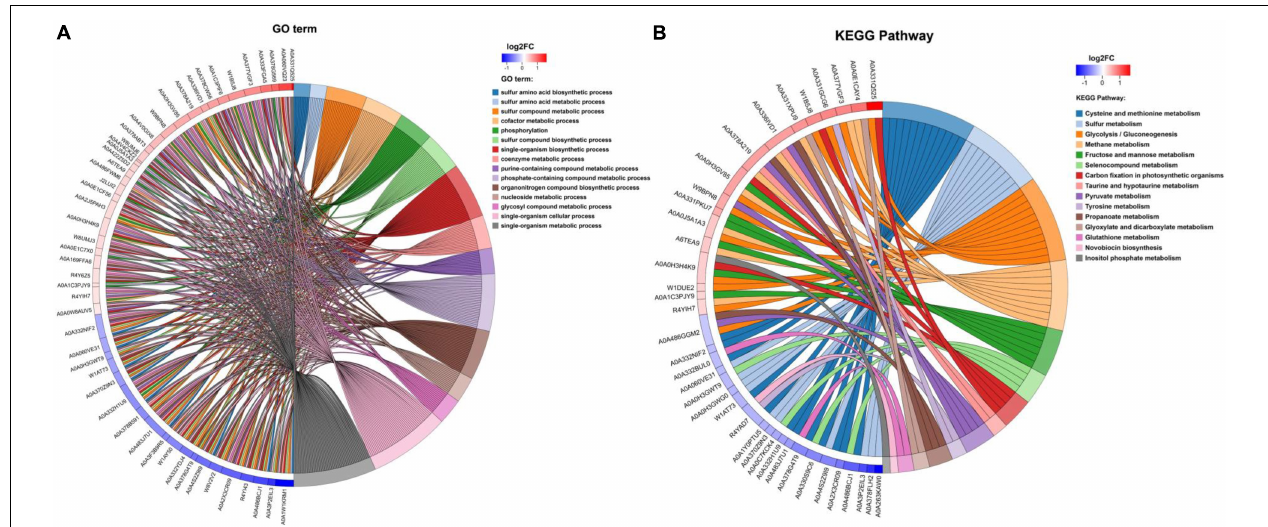
FIGURE 4 | (A) Chord diagram of GO term enrichment. (B) Chord diagram of KEGG pathway enrichment. KEGG enrichment chord diagram shows the corresponding relationship among the target proteins, the annotation, and enrichment; the left is protein, and log 2 FC is displayed from top to bottom. When log 2 FC > 0, the larger the log 2 FC is, the greater the differential expression of up-regulated protein is; when log 2 FC < 0, the smaller the log 2 FC is, the greater the differential expression of down-regulated protein is. The closer the log 2 FC is to 0, the smaller the differential expression fold is. The right is KEGG pathway and the score of z score. When z score > 0, there are more up-regulated proteins than down-regulated proteins involved in this pathway, and this pathway is more likely to be activated. On the contrary, when z score < 0, the up-regulated proteins involved in this pathway are less than the down-regulated proteins, and this pathway is more likely to be inhibited. (The same analysis is applied to GO term).